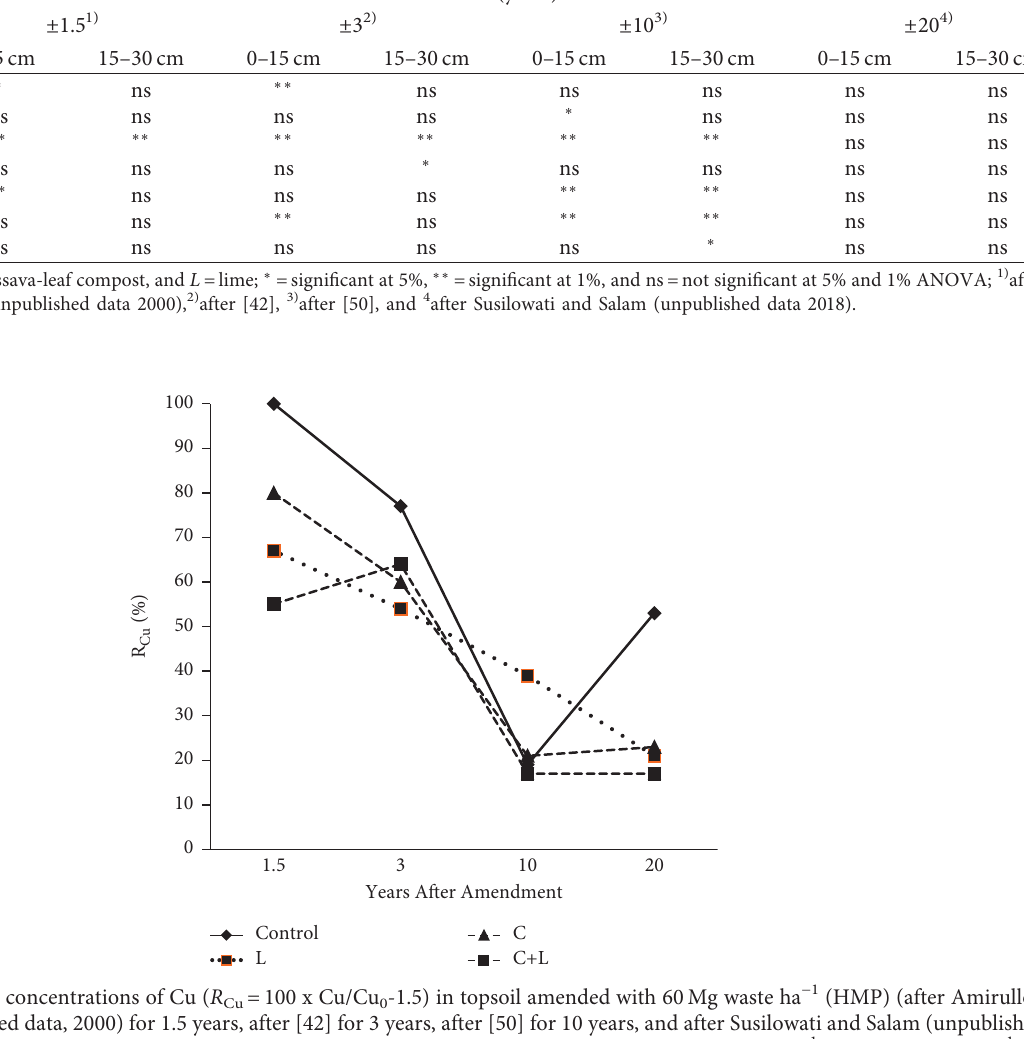
Table 5: The effect of the 20-year-old amendment of industrial waste, lime, and cassava-leaf compost on the soil pH. Treatment